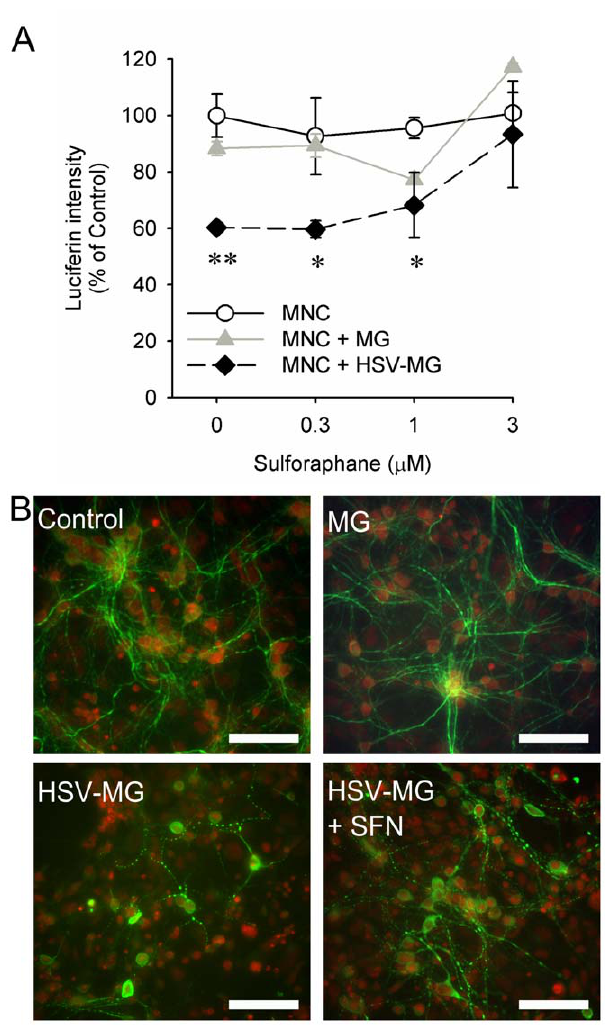
Figure 6. Sulforaphane protects mixed neural cultures from HSV-stimulated microglial neurotoxicity. Mixed neural cultures from b -actin luciferase Balb/c mice were pretreated for 24 h with SFN (0, 0.3, 1.0 and 3.0 m M). Purified murine microglia from Balb/c mice (non-luciferase expressing) were infected with HSV-1 at 2 MOI for 90 min ( + HSV 2 Mg) and added at a 1 to 5 microglia: neural cell ratio. Cultures were maintained for 48 h before analysis of neurotoxicity via ( A ) luminescence or ( B ) immunohistochemistry. Unstimulated microglia ( + Mg) and MNC or astrocyte only cultures (C) were used as controls. ( A ) Data are presented as mean luciferin intensity (% of MNC only control) 6 SD. These data are representative of 3 separate experiments. *p # 0.1; **p # 0.05. ( B ) MAP-2 immunohistochemistry (green) in MNCs alone (Control), MNCs with unstimulated microglia (MG), and MNCs with HSV- stimulated microglia alone (HSV 2 MG) or following 3 m m SFN treatment (HSV 2 MG + HSV). Cells counterstained with propidium iodide (red). Scale=50 m m.